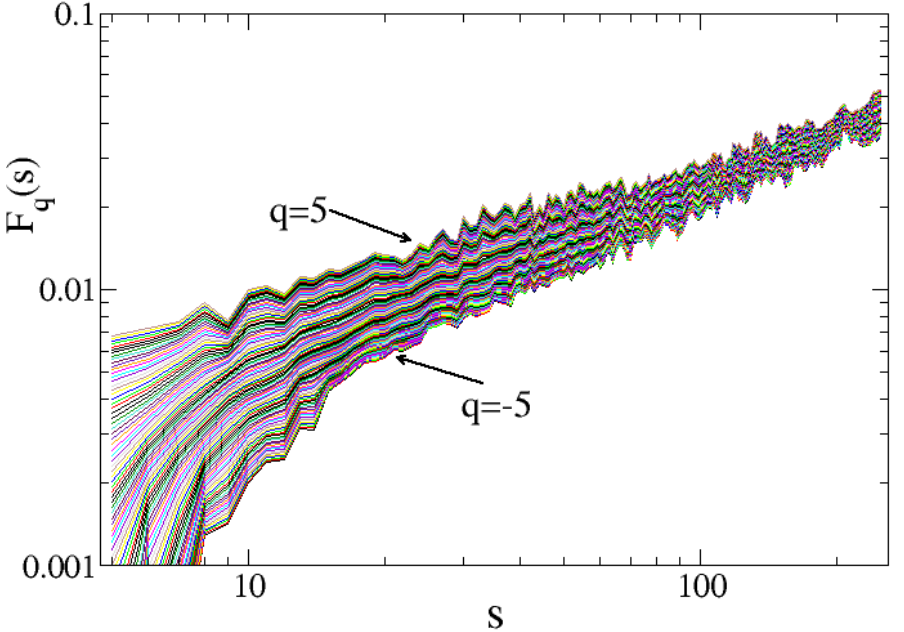
Figure 2. A representative of the fluctuation function F q ( s ) at the first time window of TOPIX time series. The results are plotted from q = − 5 (bottom) to q = 5 (up) with a step of